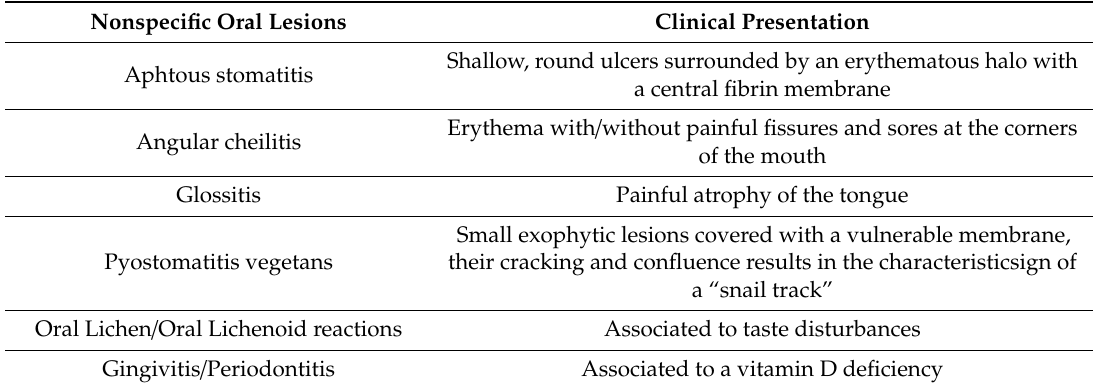
Table 1. Clinical characteristics of nonspecific oral lesions in CD.